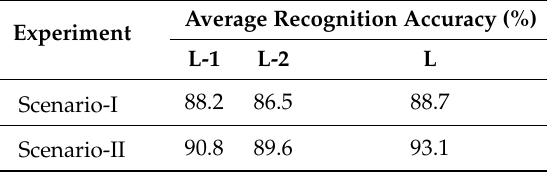
Table 7. Performance evaluation with varying